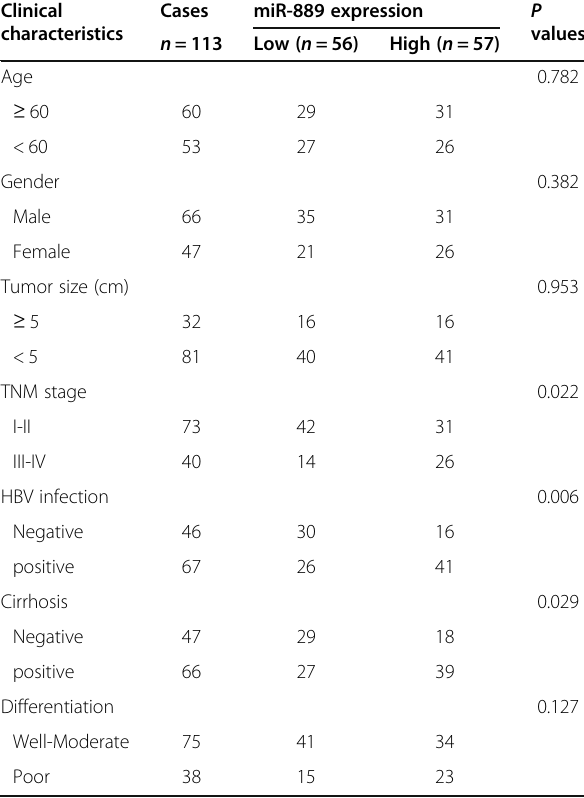
Table 1 Association between miR-889 expression and different clinical characteristics of patients with hepatocellular carcinoma Clinical